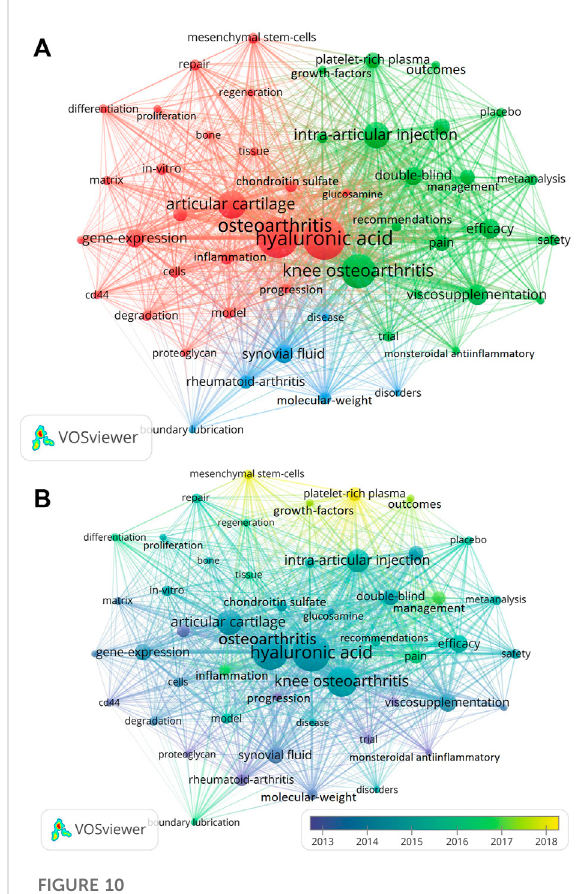
FIGURE 10 Mapping of keywords in studies on HA for the treatment